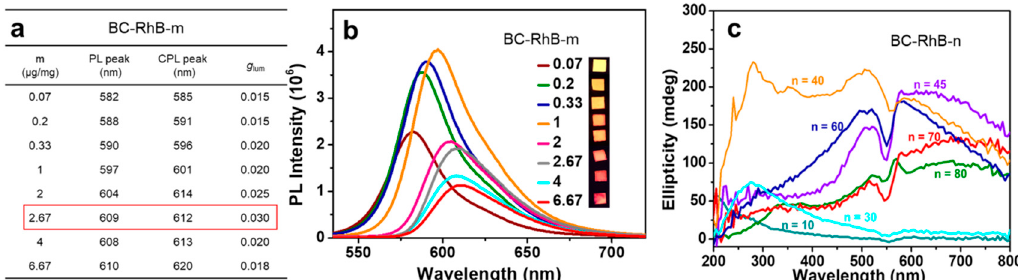
Figure 2. ( a ) BC-RhB-m enabling L-CPL of varied peak wavelengths and g lum values (m refers to RhB solution concentration in µ g/mg, paper thickness = 40 µ m). ( b ) Corresponding photoluminescence spectra and photographs of BC-RhB-m. ( c ) CD spectra of BC-paper-n (n refers to paper thickness in µ m, RhB loading = 0.67 µ g/mg).